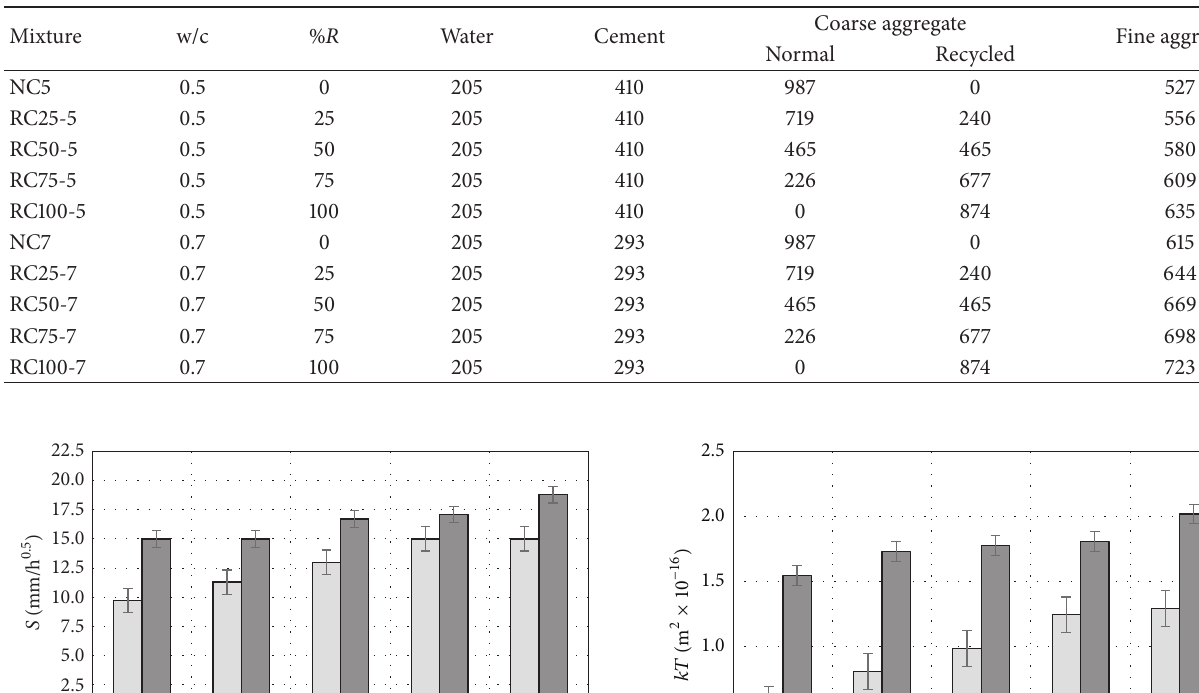
Table 4: Mixture design (kg/m 3 ).